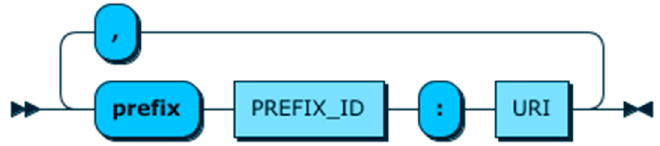
Scheme 2. Example of PREFIX clause.